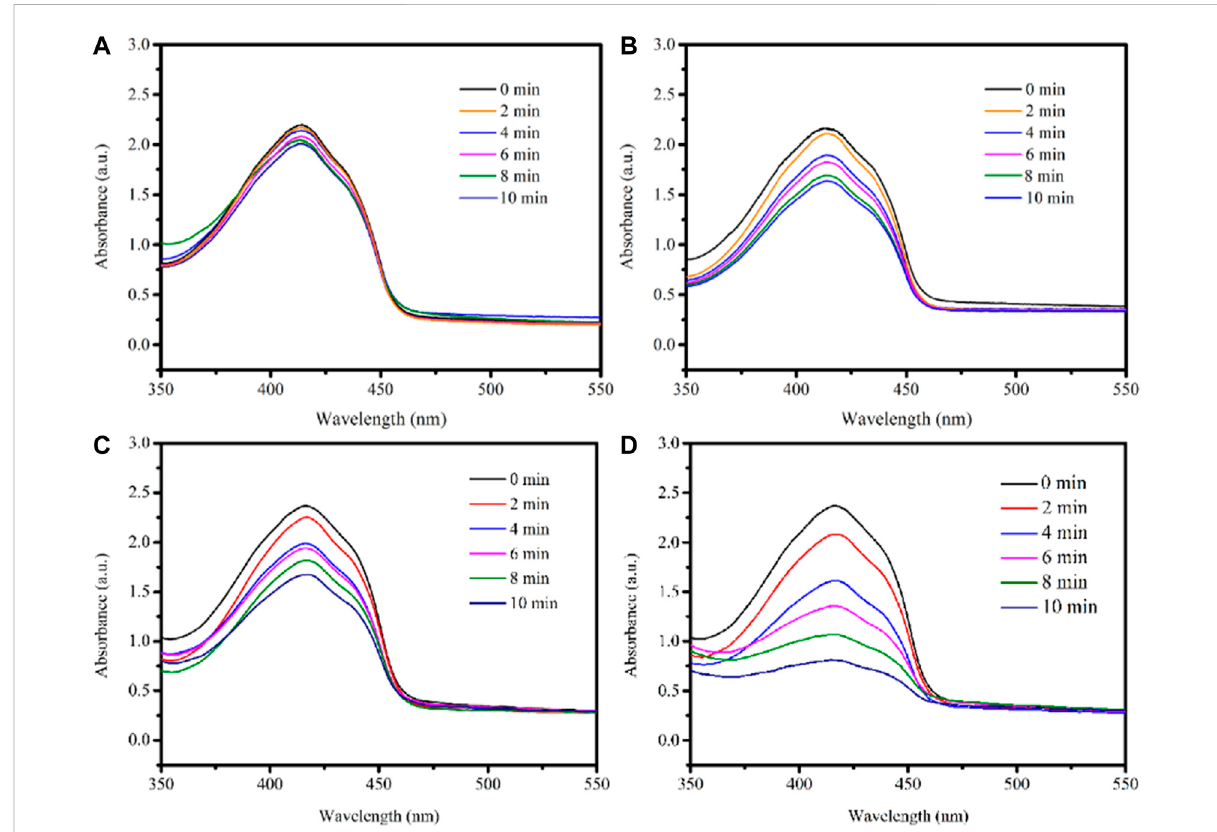
FIGURE 8 UV – Vis spectra of DPBF under laser irradiation: (A) DPBF+650 nm + 808 nm; (B) 2D MXene + DPBF+650 nm + 808 nm; (C) 3D CNT/MXene + DPBF+650 nm; (D) 3D CNT/MXene + DPBF+650 nm + 808